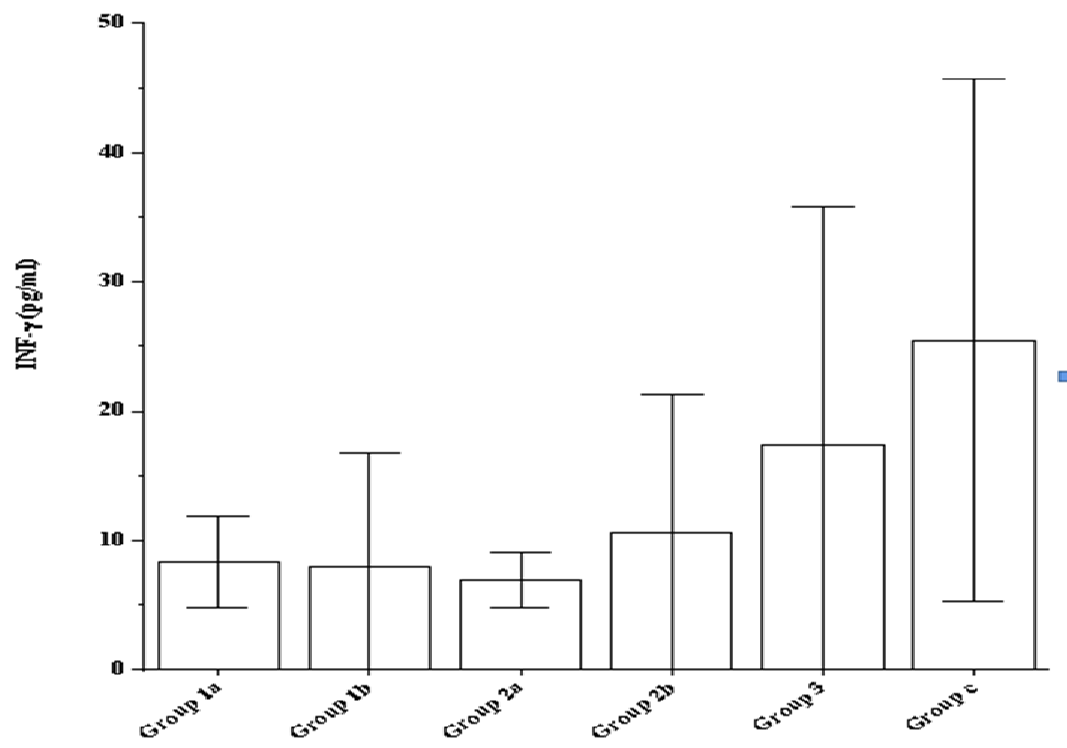
Figure 4.2 Plasma levels of IFN-γ in group 1a, group 1b, group 2a, group 2b, group 3 and group c. Bars represent mean standard